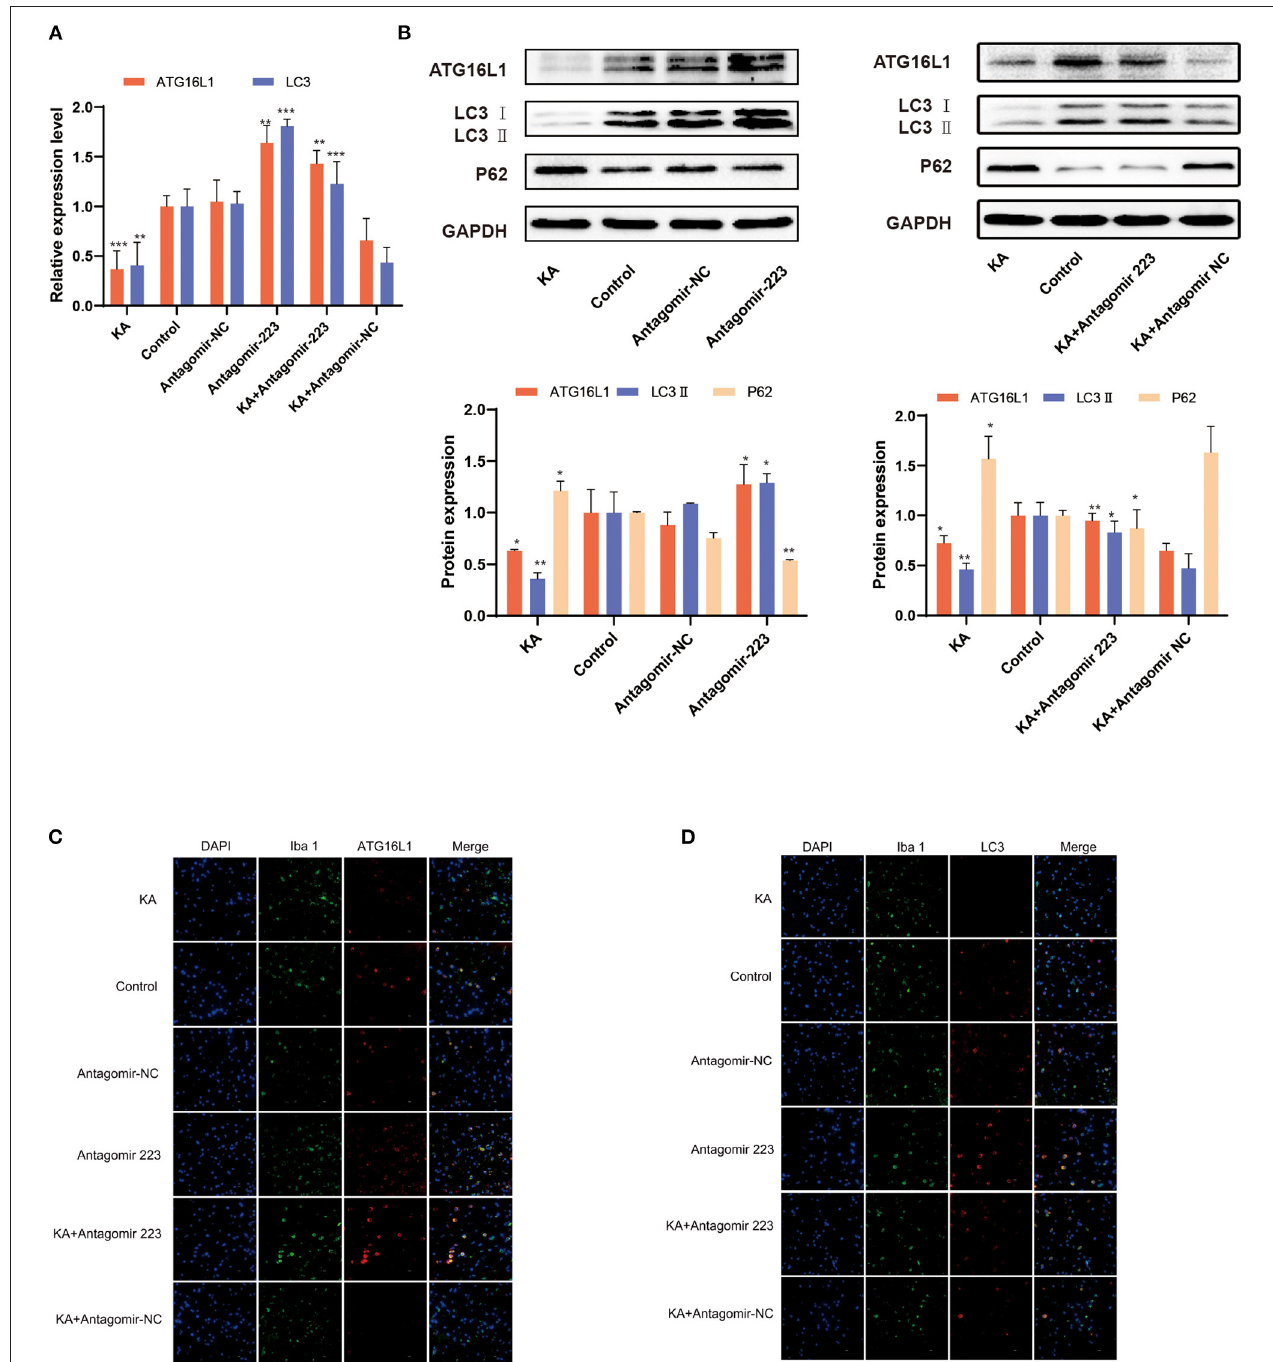
FIGURE 6 | Effects of miR 223 silencing on ATG16L1 expression and microglial autophagy. (A) The hippocampal tissues were analyzed for ATG16L1 and LC3 levels using qRT-PCR ( n = 6 per group). (B) The hippocampal tissues were analyzed to assess the ATG16L1, LC3, and P62 protein expression levels through western blotting. (C,D) ATG16L1 levels (C) and autophagy (D) were measured in the mice hippocampus. The cell-type specificity of ATG16L1 and LC3 (TxRed, red) was established by double-fluorescent immunolabeling with the microglia-specific marker Iba 1 (FITC, green). The nuclei were stained with DAPI (blue). Statistically significant differences were determined using the unpaired t -test. Data are presented as means ± SD ; * p < 0.05; ** p < 0.01; *** p < 0.001. Scale bar = 10 µ m. miR, microRNA; TLE, temporal lobe epilepsy; SD, standard deviation; LC3, light chain 3.